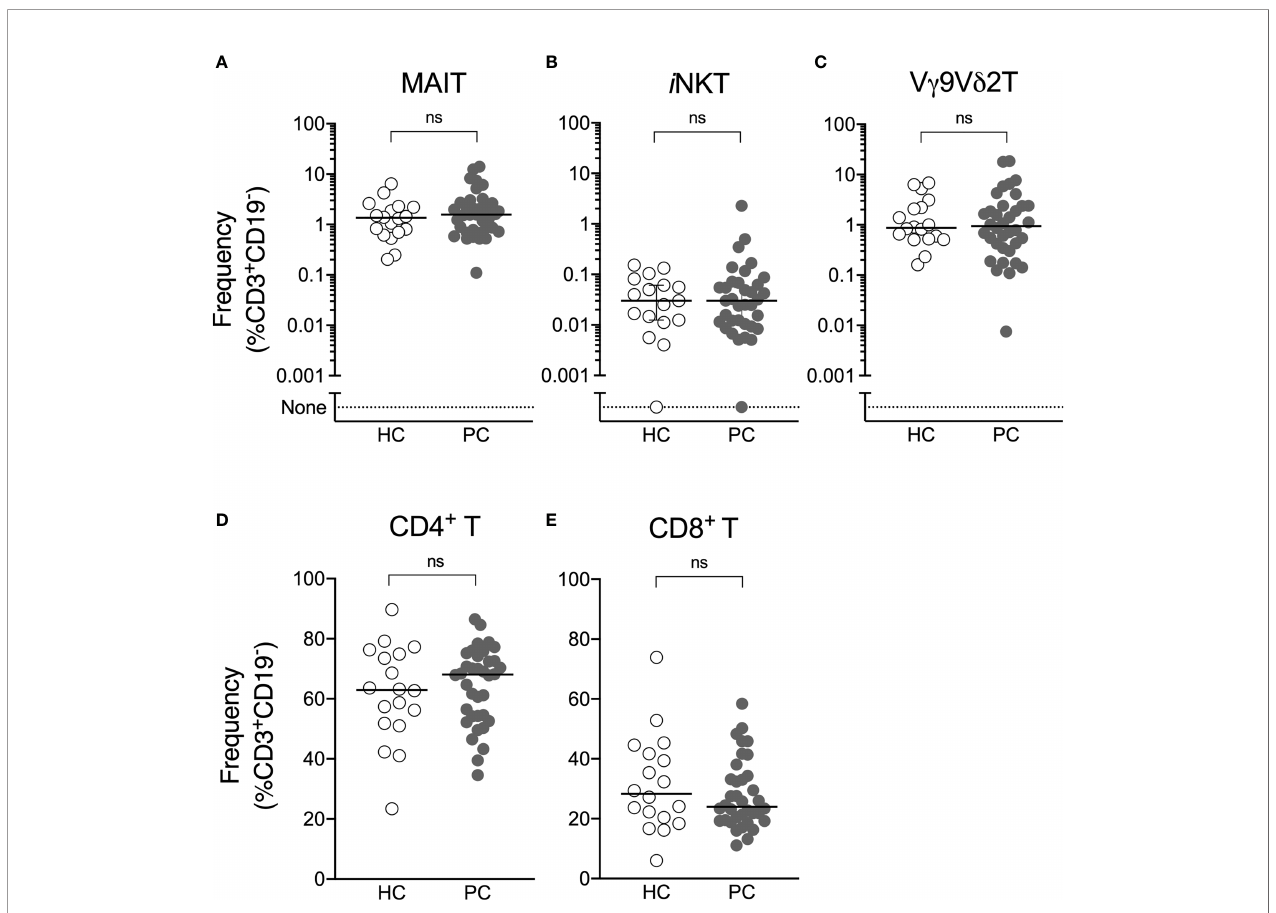
FIGURE 1 | Circulating ILT-cell frequencies are preserved in men with prostate cancer. Flow cytometric analysis was used to determine the proportion of MAIT (A) , NKT (B) , V g 9V d 2T (C) , CD4 + (D) and CD8 + (E) T-cells between men with prostate cancer and healthy male controls. Mann-Whitney test. N = 20 healthy controls, 36 men with prostate cancer. ns, no signi fi